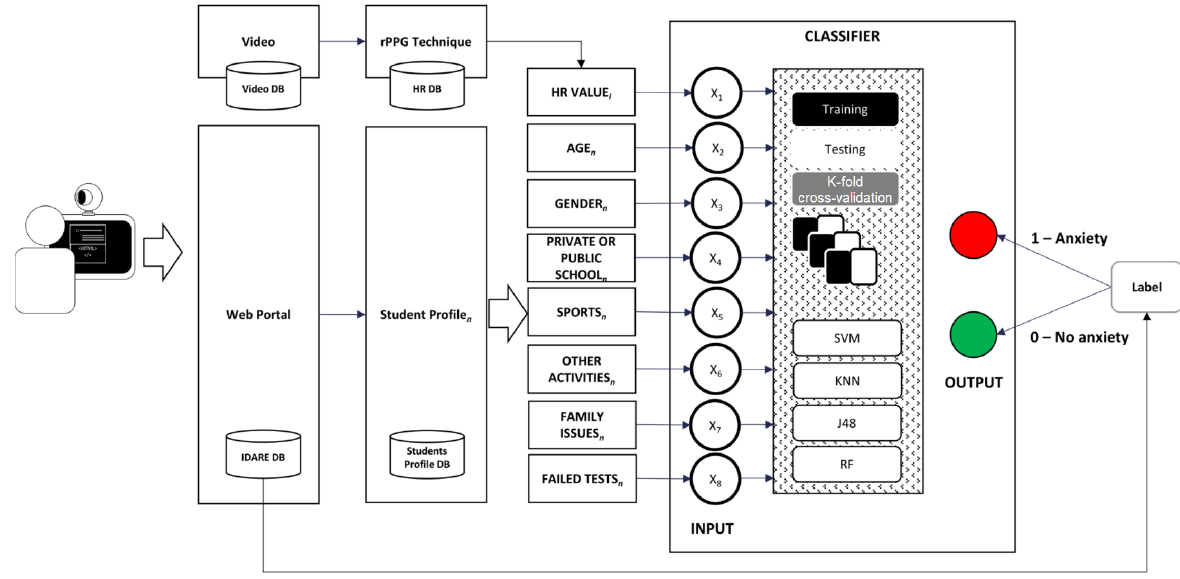
Figure 3. Classification phase uses eight features that are labeled to academic stress